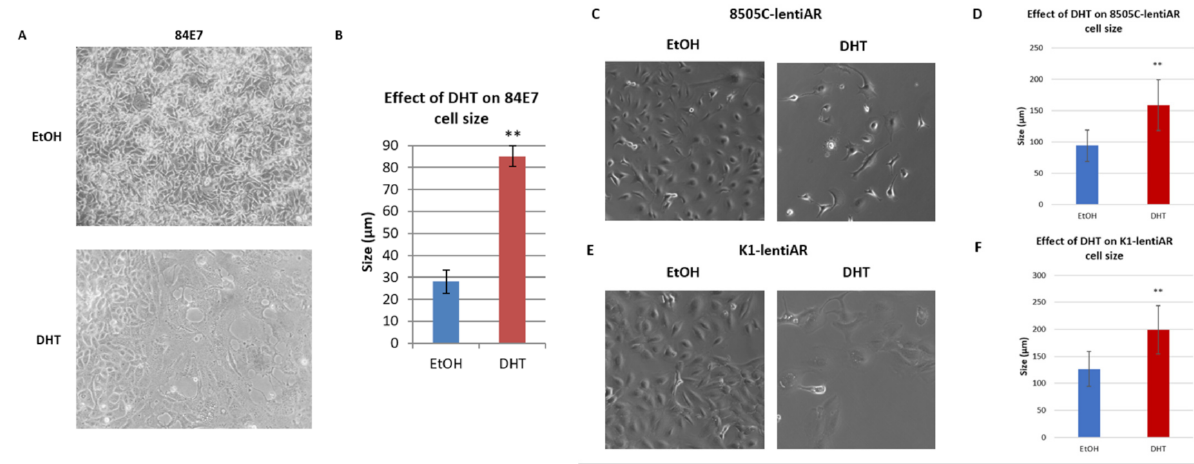
Figure 3. Effect of prolonged androgen receptor activation on cell morphology and size: ( A ) 84E7 cells enlarged in size by day 9 of continuous androgen receptor activation. ( B ) Quantification of 84E7 AR-activation modulation of cell size. ( C ) 8505C-lentiAR cell morphology and size were modulated by day 6 of continuous androgen receptor activation. ( D ) Quantification of 8505C-lentiAR cell size with 6 days of AR activation. ( E ) K1-lentiAR cell morphology and size were modulated by day 6 of continuous androgen receptor activation. ( F ) Quantification of K1-lentiAR cell size with 6 days of AR activation. Raw numbers are representative of unbiased cell dimension measurement in five random fields of view per sample. The asterisks indicate a statistically significant difference (** p < 0.005) seen between the control and treated cells. Results represent 3 separate experiments performed on different days at 20 ×